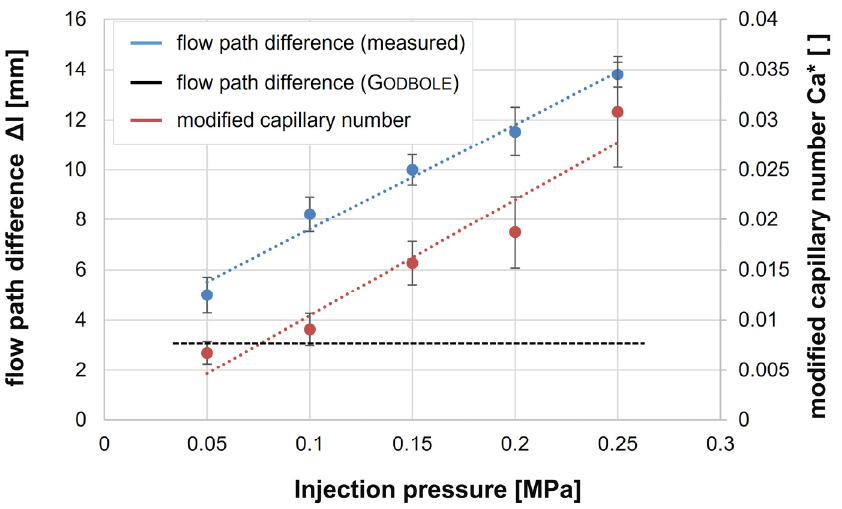
Figure 9. Dependence of the flow path difference and modified capillary number on the injection pressure.